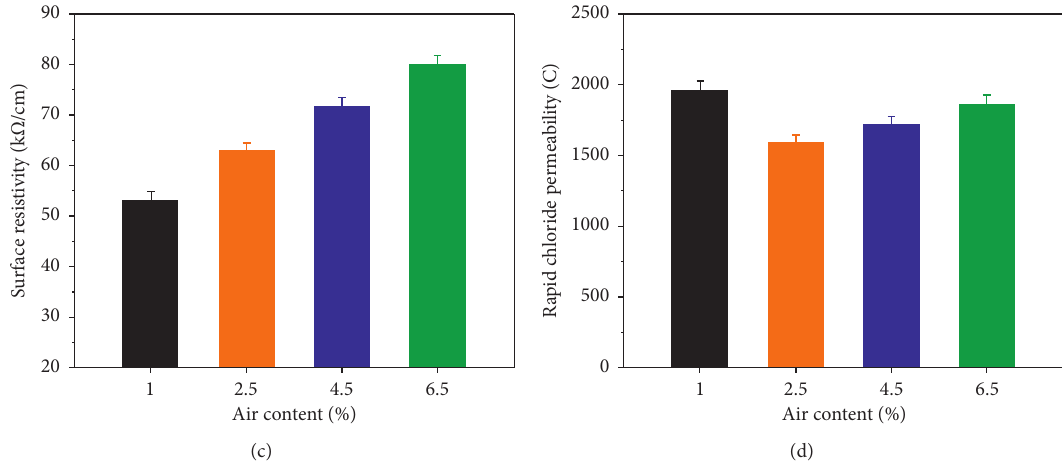
Figure 9: Influence of air contents on the performances of concrete. (a) Compressive strength. (b) Flexural strength. (c) Surface resistivity. (d) Rapid chloride